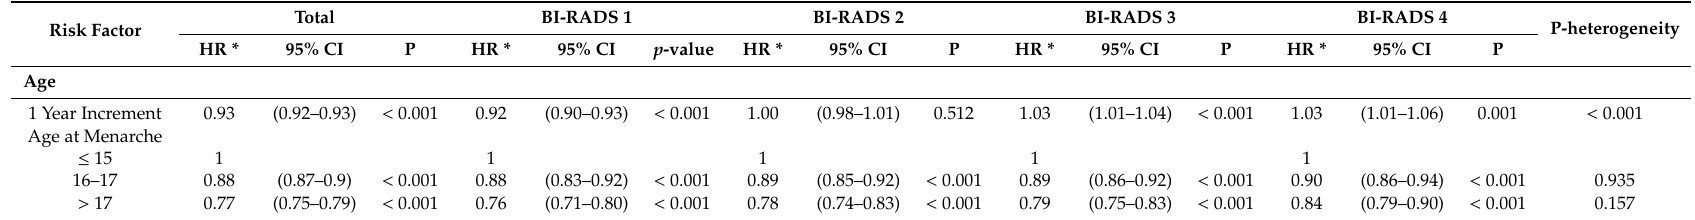
Table 2. Association between known risk factors of breast cancer and breast cancer development by breast density, in consideration of their interaction on breast cancer risk. Risk